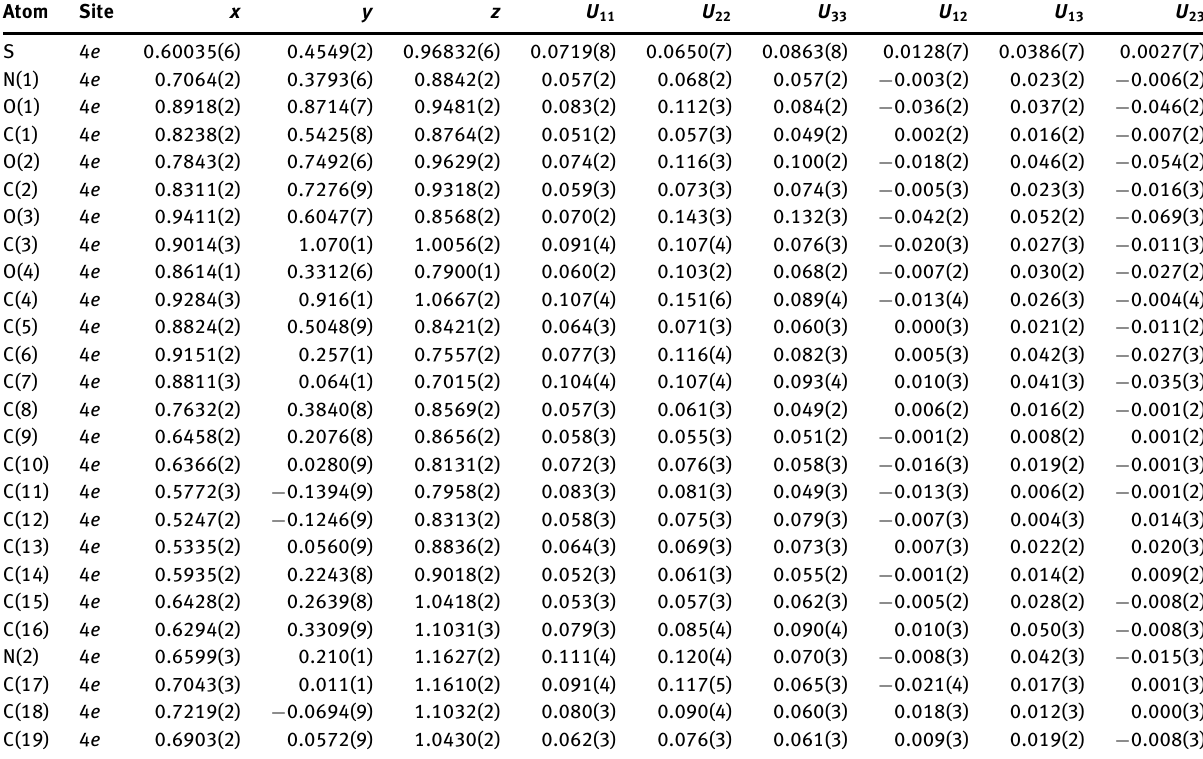
Table 3: Atomic displacement parameters (Å 2